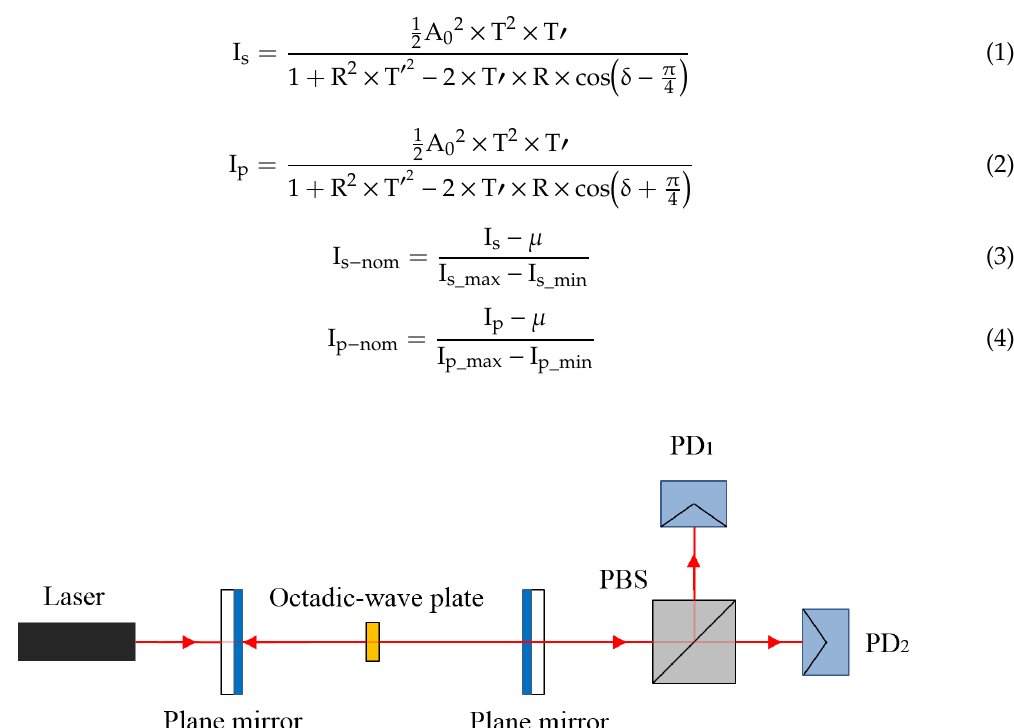
Figure 2. The optical arrangement of polarized Fabry–Pérot interferometer. PBS, polarizing beam splitter; PD, photodiode.